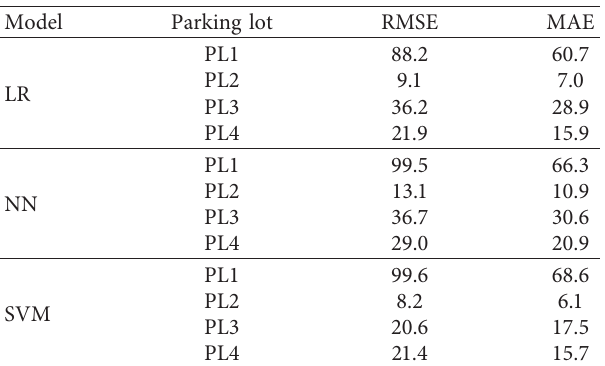
Table 3: Forecasting results of the four parks with FM2.